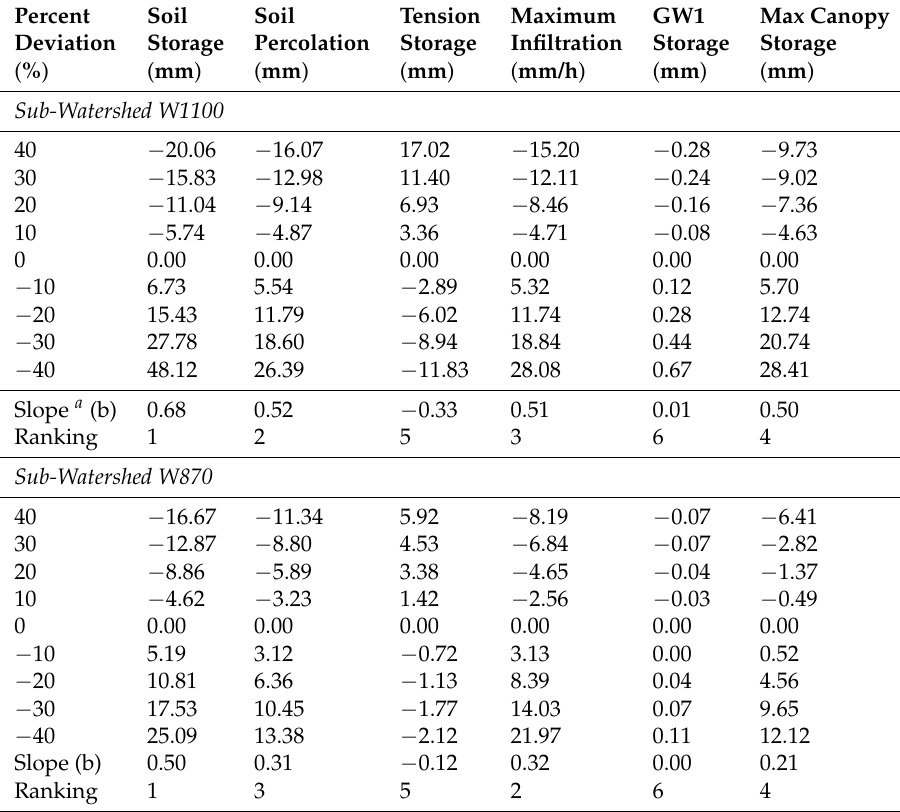
Table 4. Sensitivity of SMA parameters tested in Sub-watersheds W1100 and